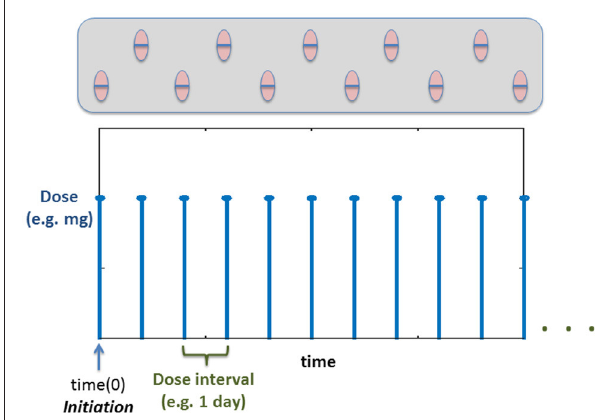
FIGURE 3 | “Growth” as implemented in the model. The arterial lumen (in white) would be remodeled as a consequence of volume growth (inner region of the artery) due to plaque formation and development in time (in yellow).